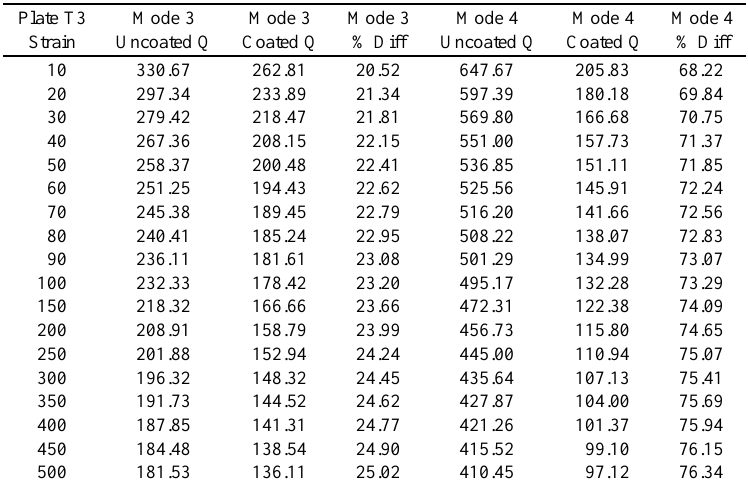
Table 5 Uncoated versus coated Q comparison at different strains for plate